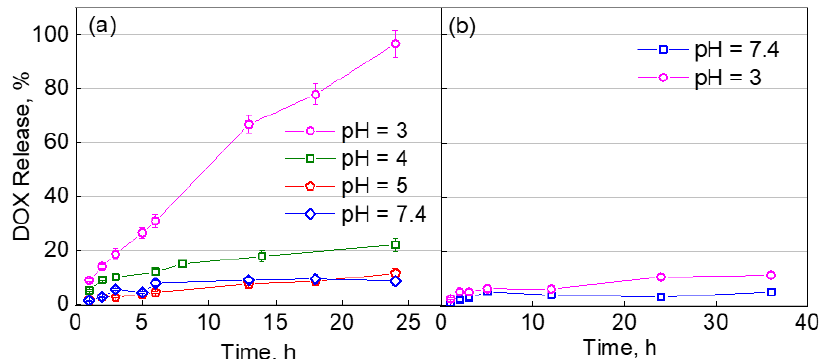
Figure 5. Accumulative release of DOX (%) from ( a ) DOX-loaded PVCL 10 -PDMS 65 -PVCL 10 vesicles incubated at 37 °C and pH = 7.4 (diamonds), pH = 5 (pentagons), pH = 4 (squares), and pH = 3 (circles), and ( b ) DOX-loaded PMOXA 14 -PDMS 65 -PMOXA 14 polymersomes at 37 °C and pH = 7.4 (squares) and pH = 3 (circles).